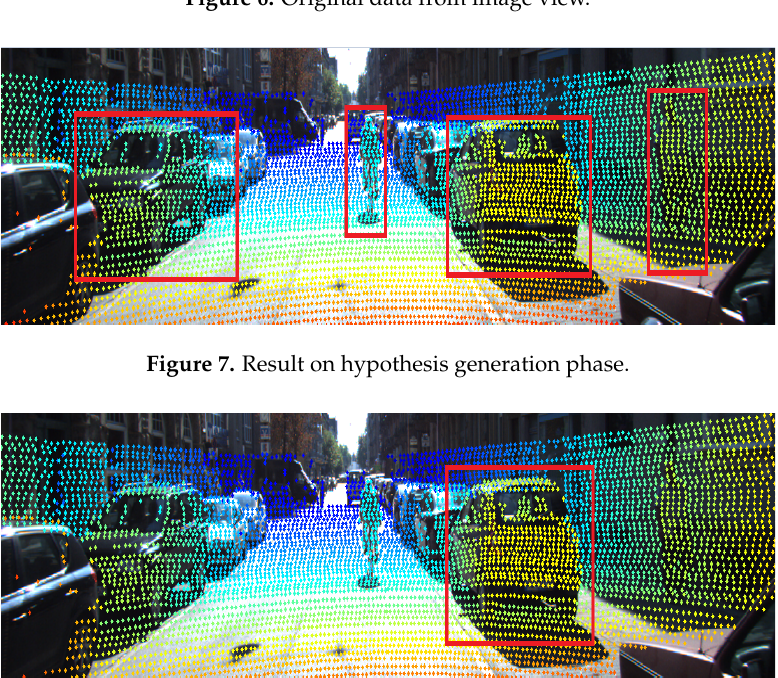
Figure 6. Original data from image view.